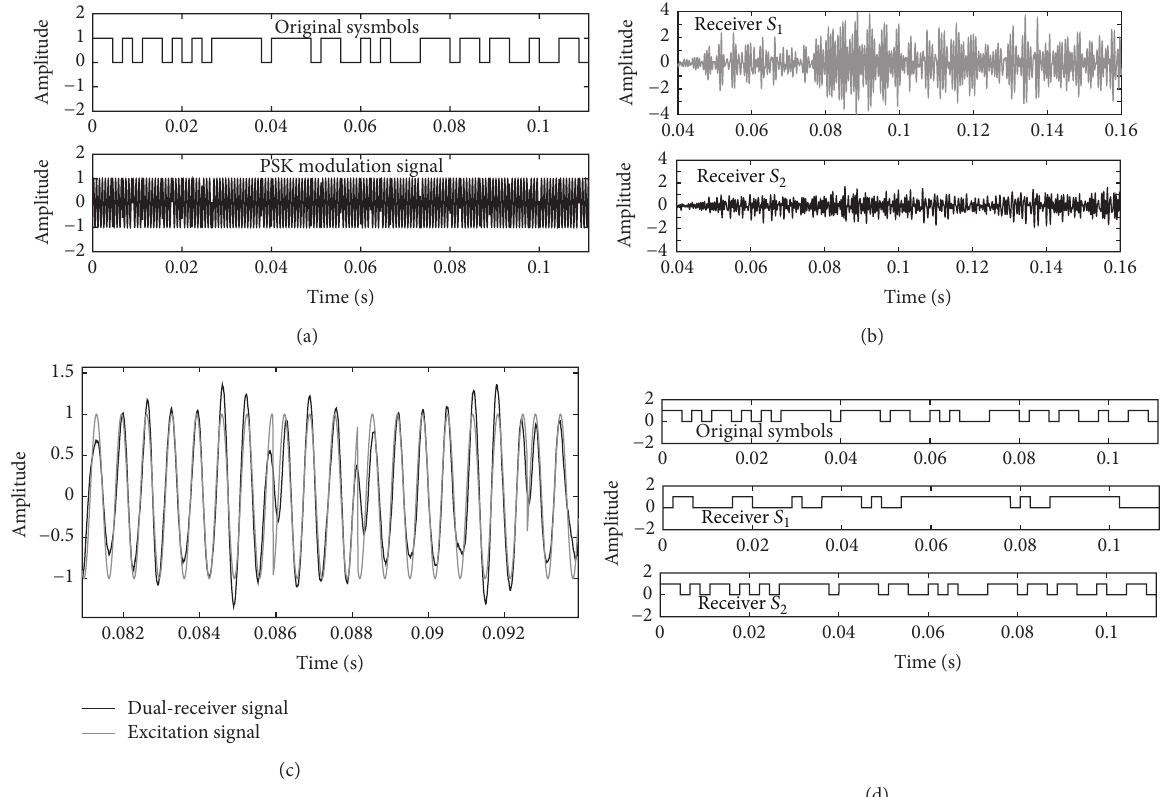
Figure 7: Simulation results of transmitted and received PSK-modulated data. (a) Excitation signal, (b) received signal at the receivers 𝑆 1 and 𝑆 2 , (c) magnification of dual-receiver signal, and (d) recovered binary